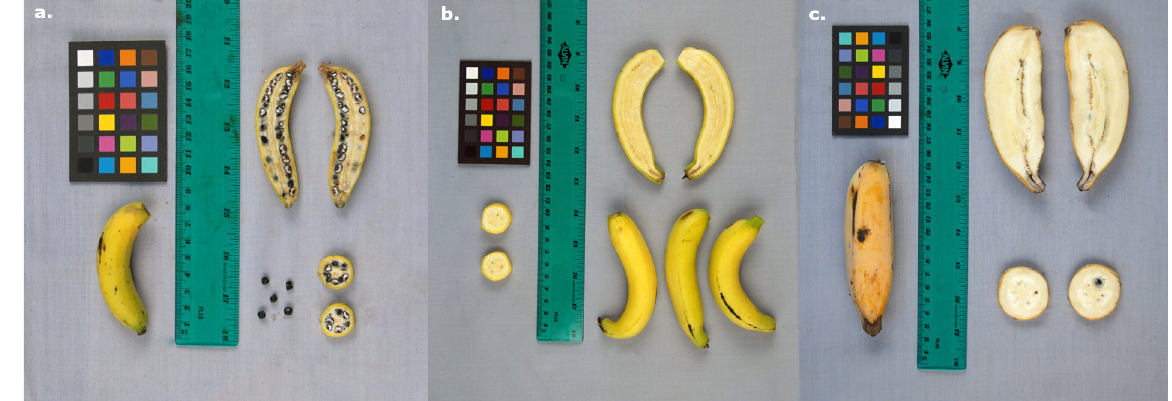
Fig 1. Fruits of a. M . acuminata banksii ITC0766 ‘ Paliama ’ , wild and seeded, b. diploid AA ITC1121 ‘ Pisang Lilin ’ (synonym of ITC0395 ‘ Lidi ’ ) cultivated and unseeded and c. triploid ABB ITC0361 ‘ Blue Java ’ cultivated and occasionally setting seeds. Credits: B. Irish (USDA-ARS) for the Taxonomic Reference Collection